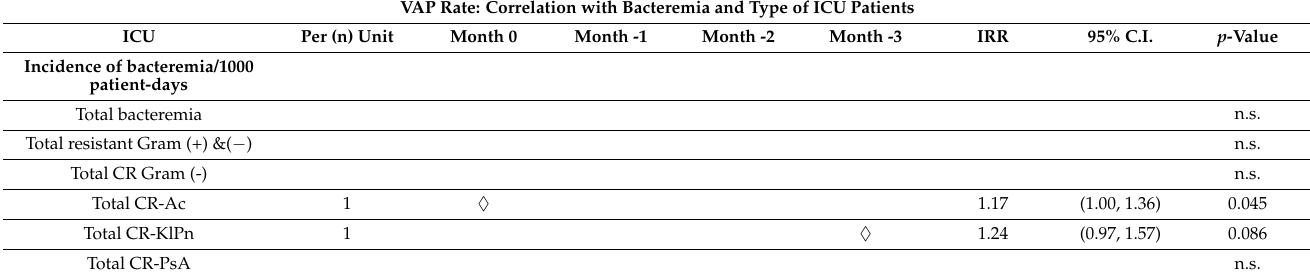
Table 5. Correlation between incidence of VAP, bacteremia from MDR pathogens, and type of ICU patients in an ICU, January 2013 to December